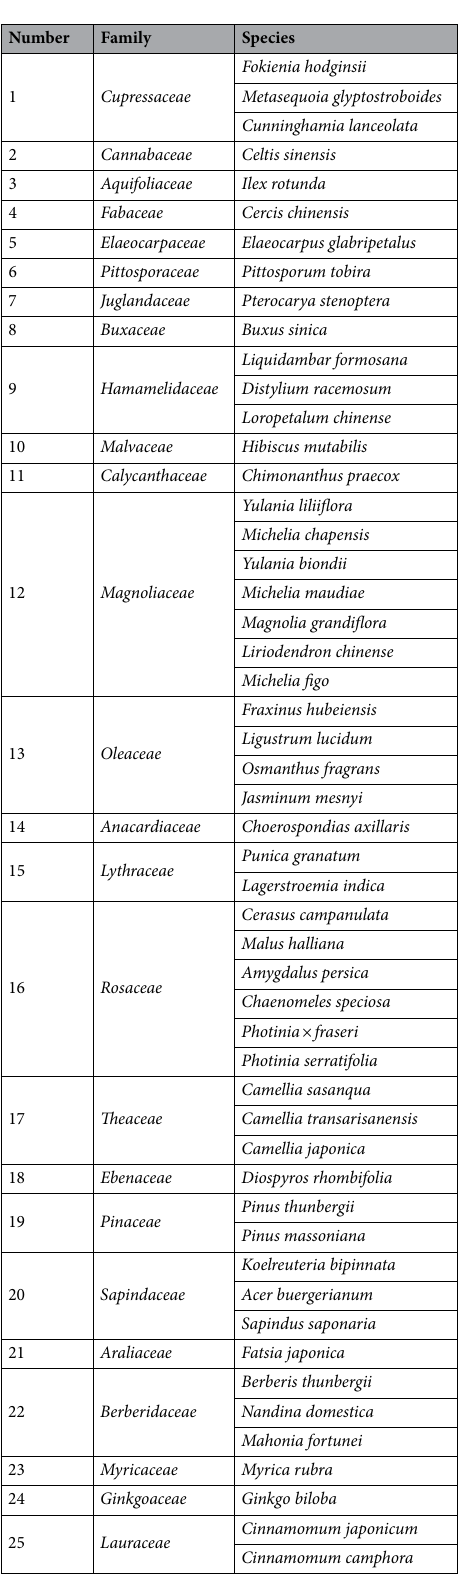
Table 1. The native greening plants and their families selected in this